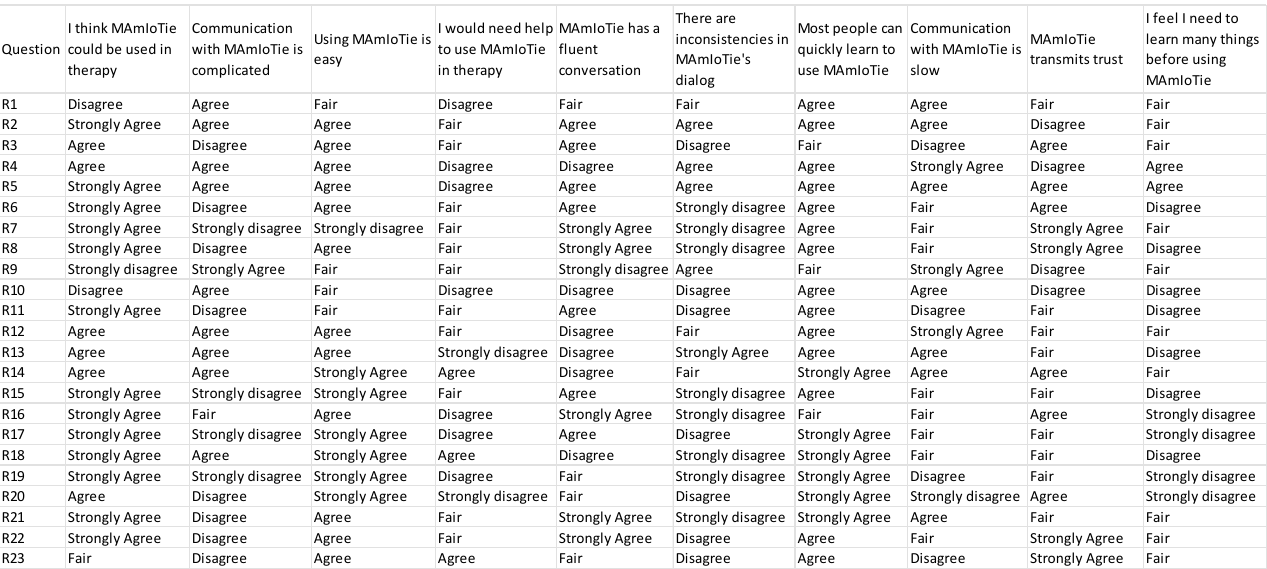
Figure A2. Questionnaire results.